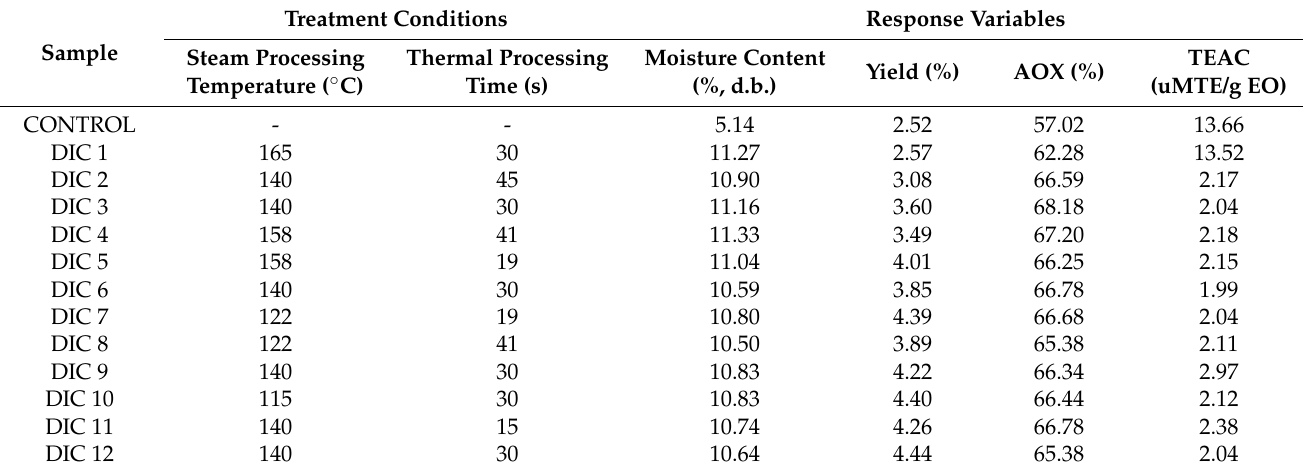
Table 1. Effect of DIC treatment on cardamom seeds moisture content, essential oil yield, and antioxidant